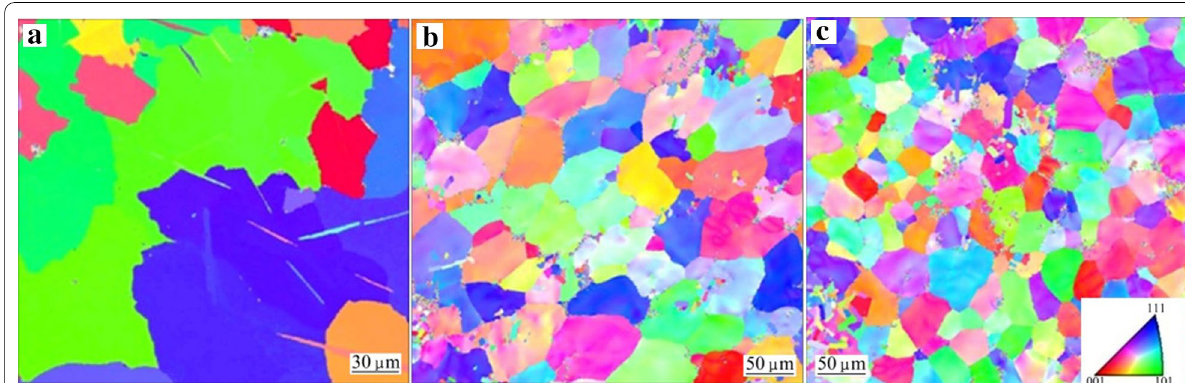
Figure 4 EBSD maps of AA6061/TiC in-situ composites containing TiC: a 0, b 2.5%, c 5% [29]